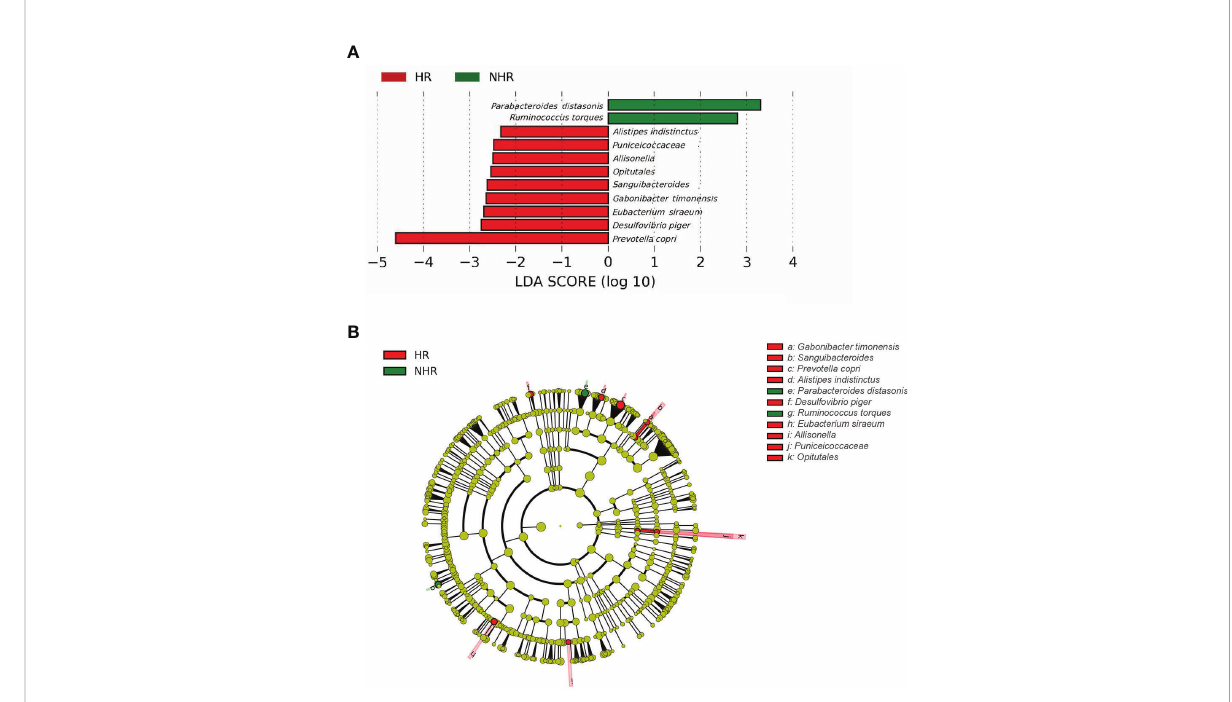
FIGURE 2 Results of different taxa (screened by P value <0.05) between two groups by LEfSe analysis. (A) Histogram of LDA value distribution. (B) Cladogram plots depicting the microbial taxa that differed signi fi